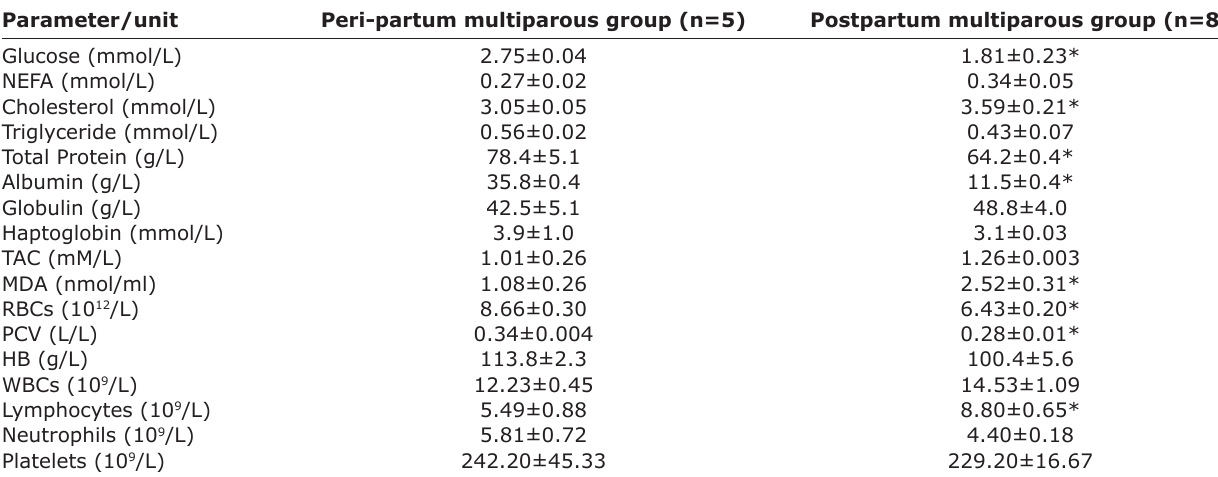
Table-2: Metabolic, oxidative stress, and hematologic profile in multiparous cows before and after parturition. Parameter/unit